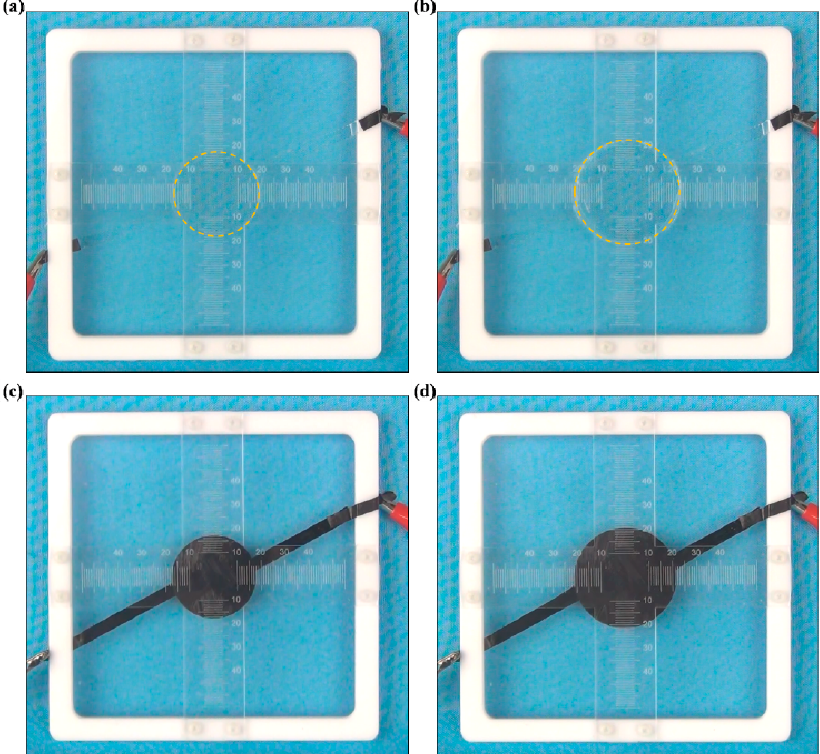
Figure 6. Expansion of the flexible actuator via a sinusoidal voltage: ionogel conductor when the voltage is ( a ) off, ( b ) on; carbon grease conductor when the voltage is ( c ) off, ( d ) on.